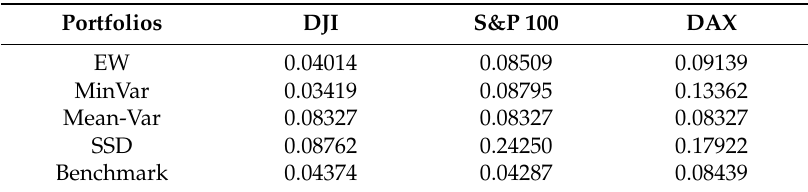
Table 1. Expected yearly returns of portfolios. EW, Equally Weighted; MinVar, Minimum Variance; Mean-Var, Mean-Variance; SSD, Second-Order Stochastic Dominance.